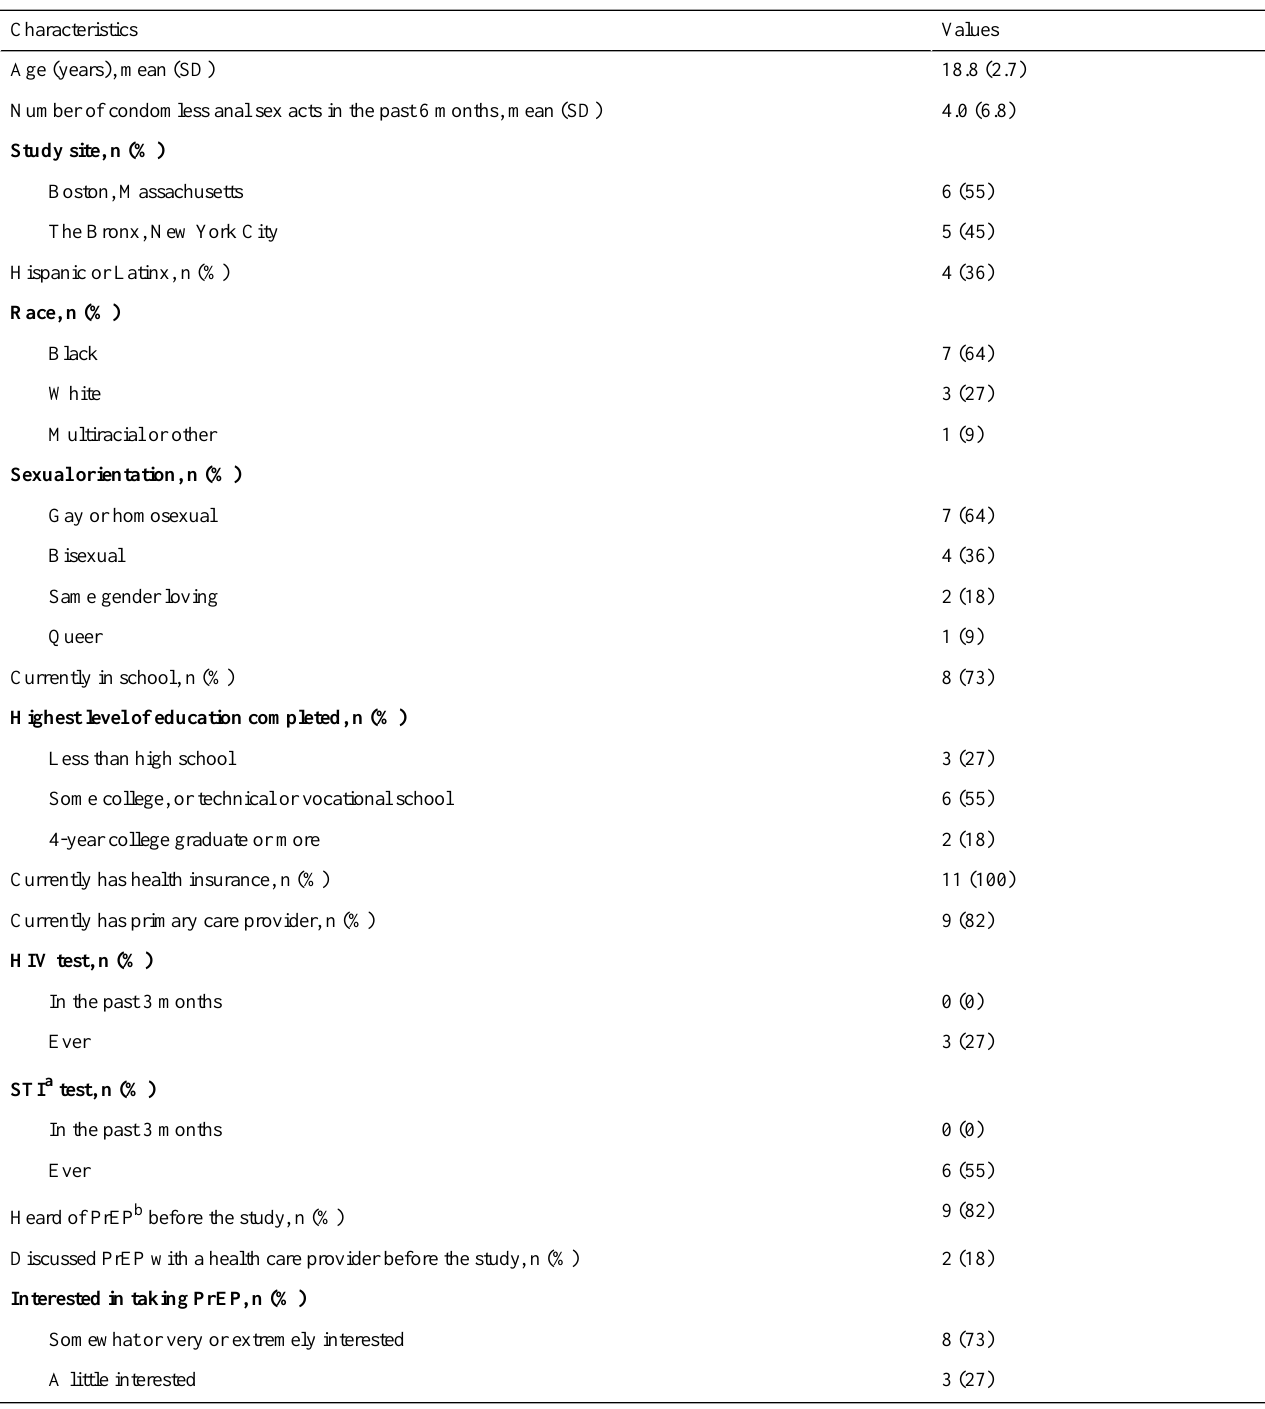
Table 2. Baseline demographic characteristics of participants in the technical pilot of a novel HIV prevention app for HIV prevention in young men who have sex with men in in Boston, Massachusetts, and the Bronx, New York City, 2019